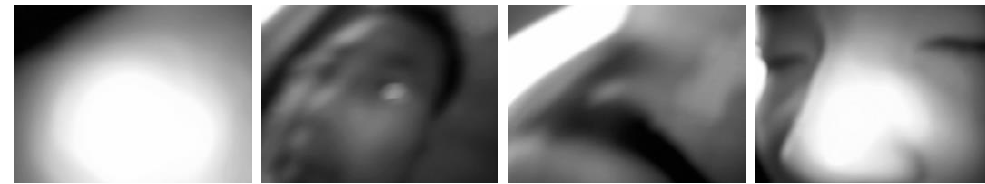
Figure 6. The example of an image that may be acquired before the eye is pointed at the